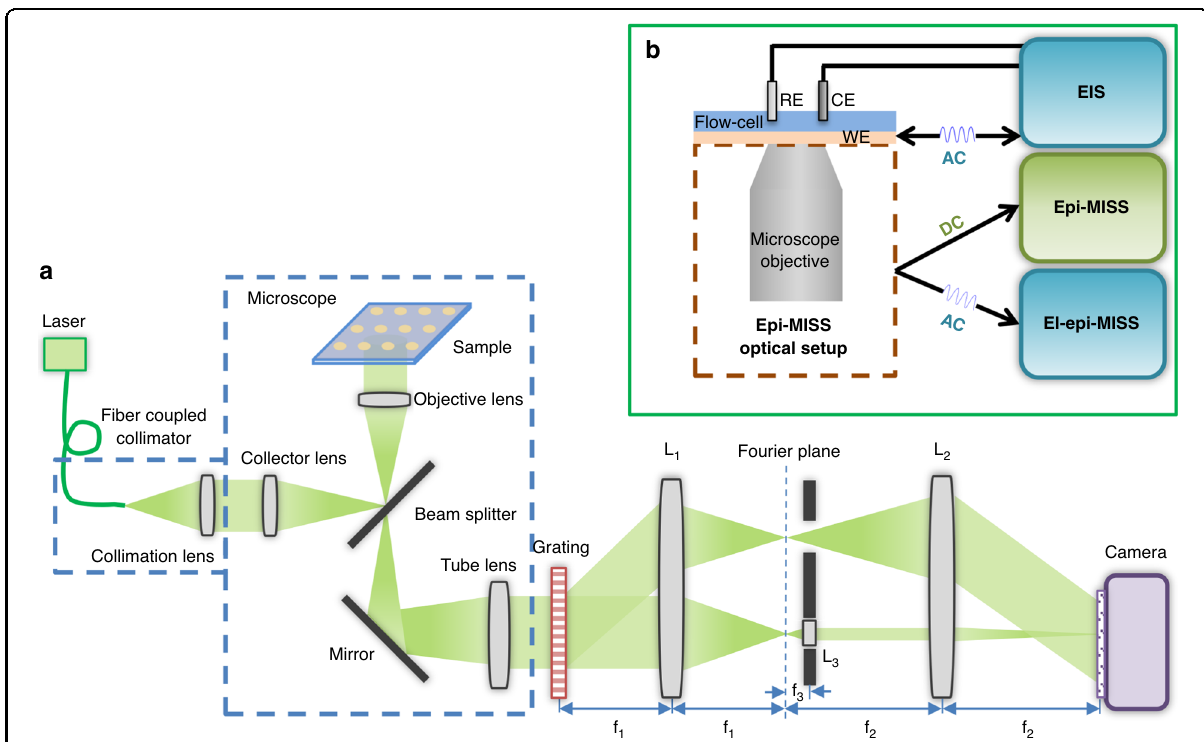
Fig. 1 Schematics of the measurement system. a The epi-MISS optical set-up based on an inverted microscope, a grating and magni fi ed image spatial spectrum based on a 4-f system with a gradient-index, GRIN, lens ( f 1 = 60 mm, f 2 = 150 mm, f 3 = 0.3 mm; L 3 and L 2 form a 4-f system that magni fi es the Fourier transform of the zero-order by a factor of 500); b Schematic representation of an optoelectrochemical cell with CE, RE, and WE and of the measuring